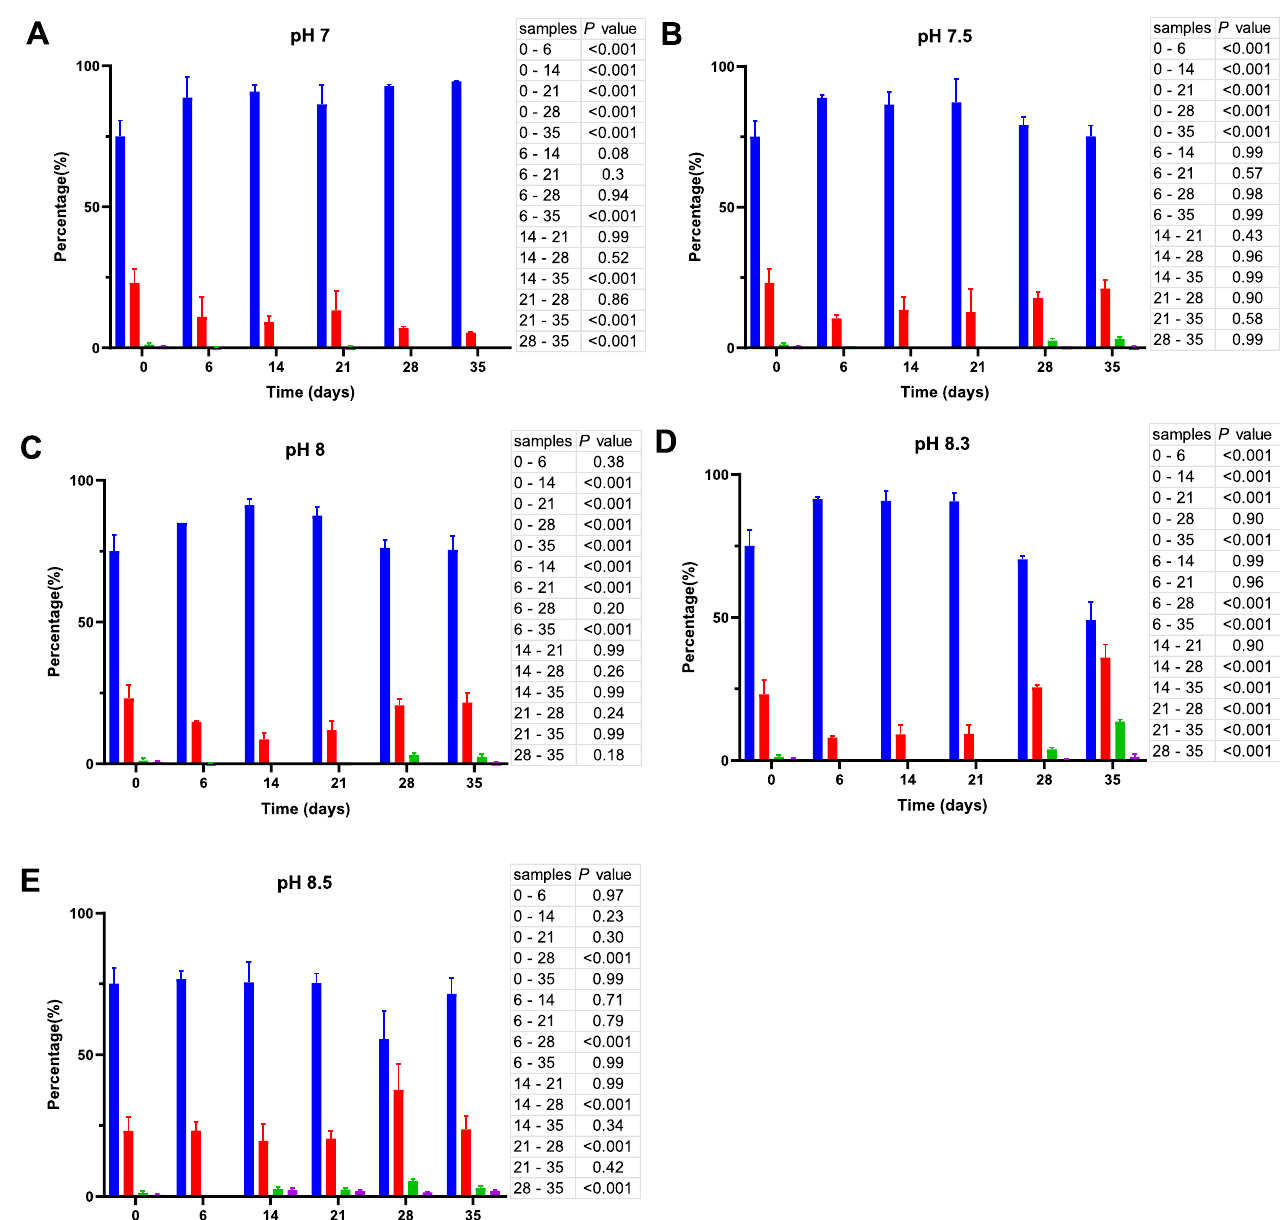
Figure 4. Cell size distribution at 20 °C. Cells are grouped according to their measured size ≤ 0.95 ( █ ); >0.95– ≤ 1.3 (